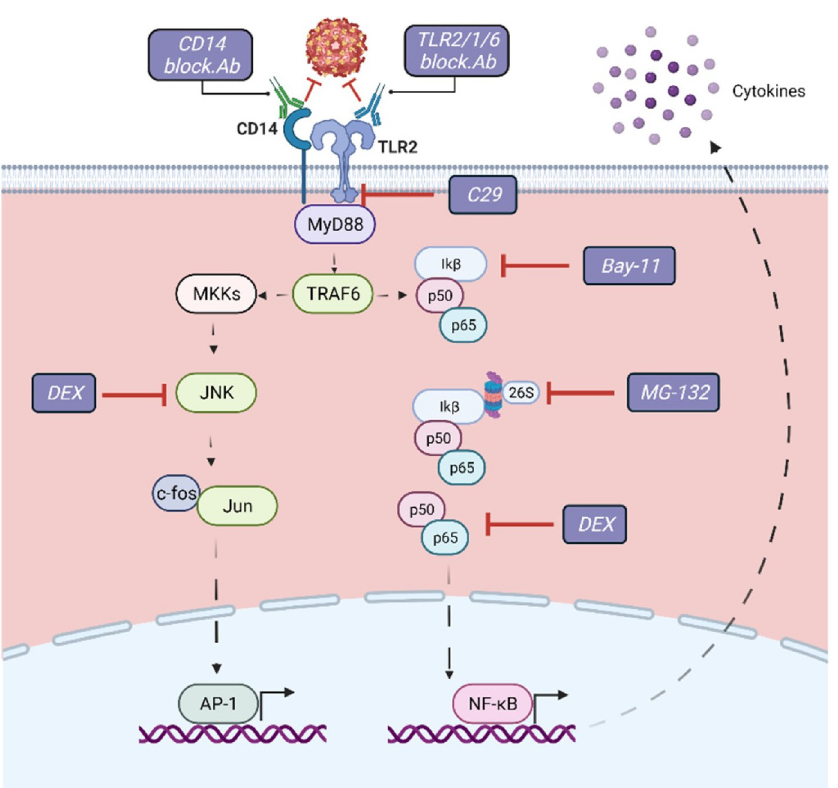
Fig 3. Schematic representation of the signaling pathways and molecules subjected to pharmacological targeting downstream TLR2 axis. C29 (C16H15NO4) is a TLR2 inhibitor that blocks the interaction of the receptor TIR domain with MyD88; Dexamethasone (DEX) blocks NF- κ B and MAPK activation during TLR engagement; Bay- 11inhibits the phosphorylation of IkB which results in the inactivation of NF-kB; MG-132 inhibits the degradation of I κ B by blocking the proteolytic activity of the 26S proteasome. Figure was created with BioRender.com.